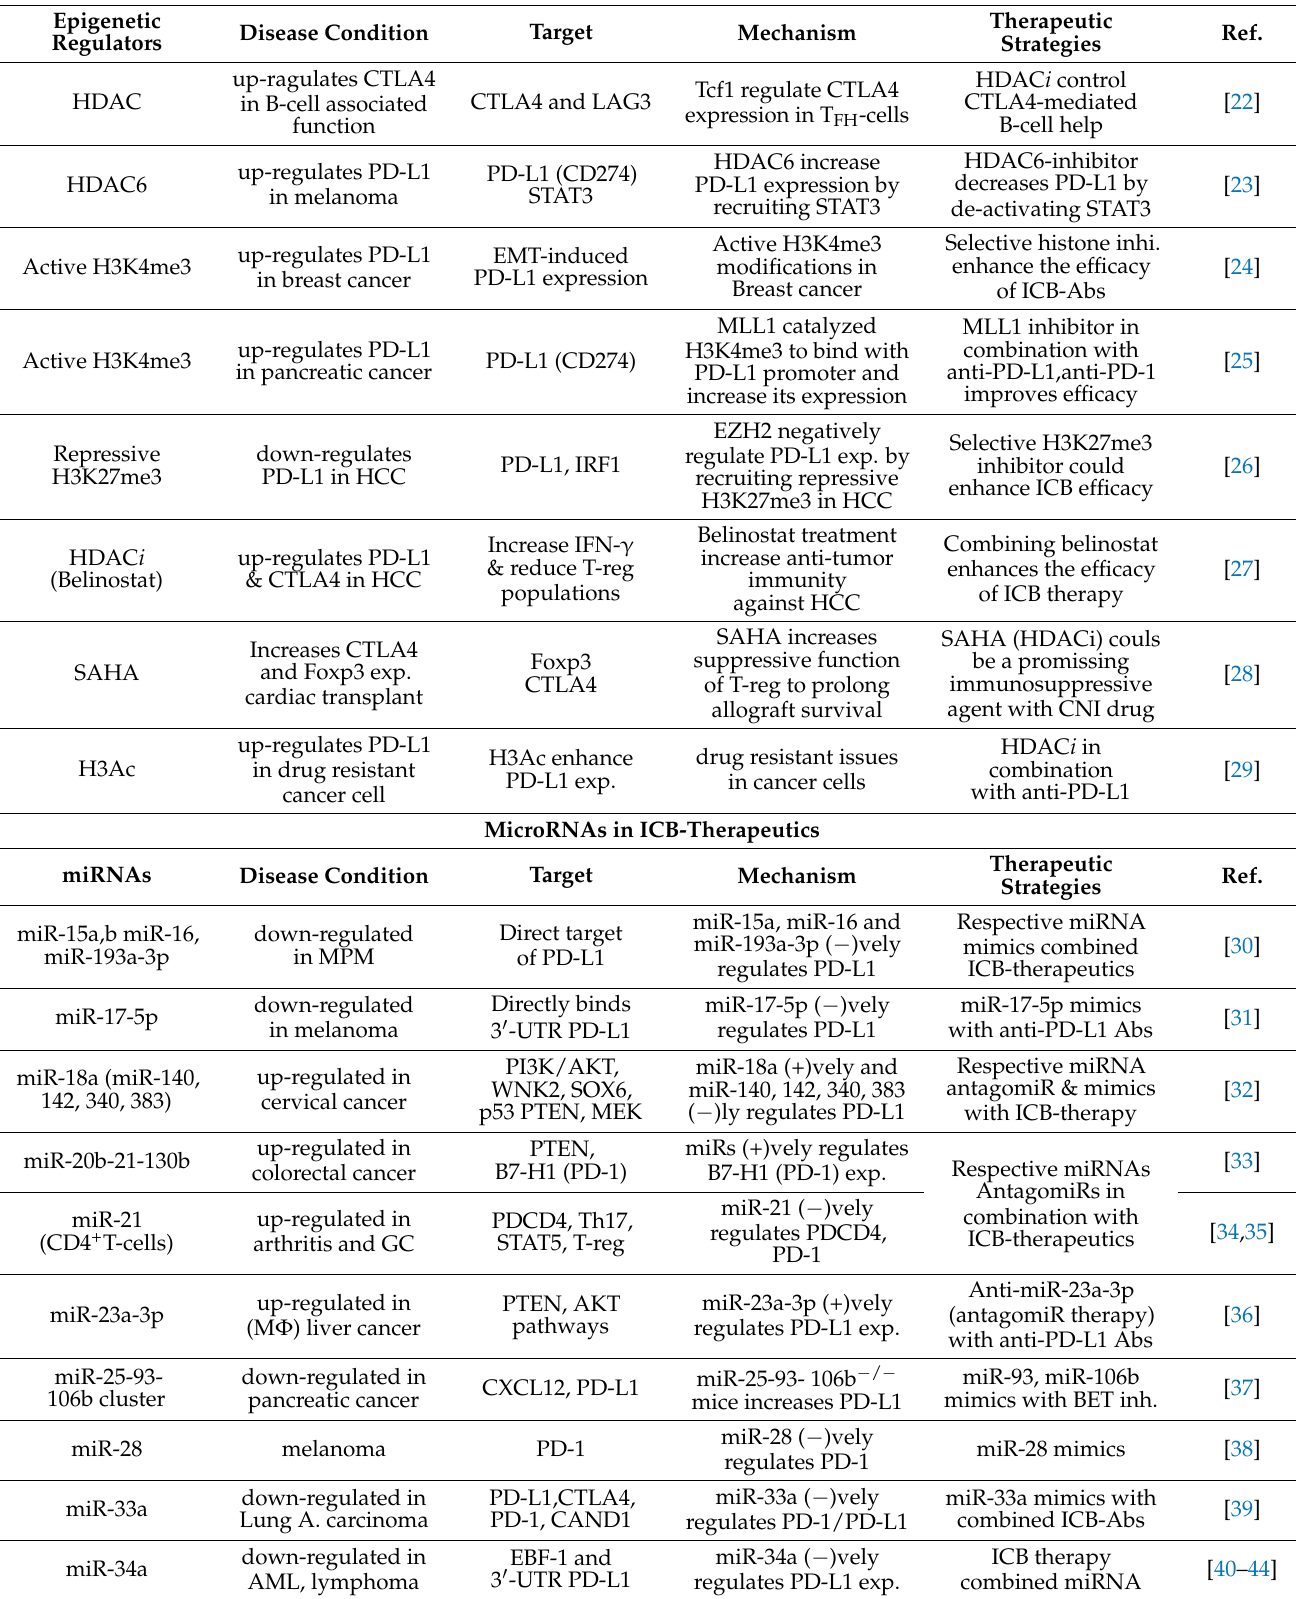
Table 1. Cont. DNA and Histone Modifiers in